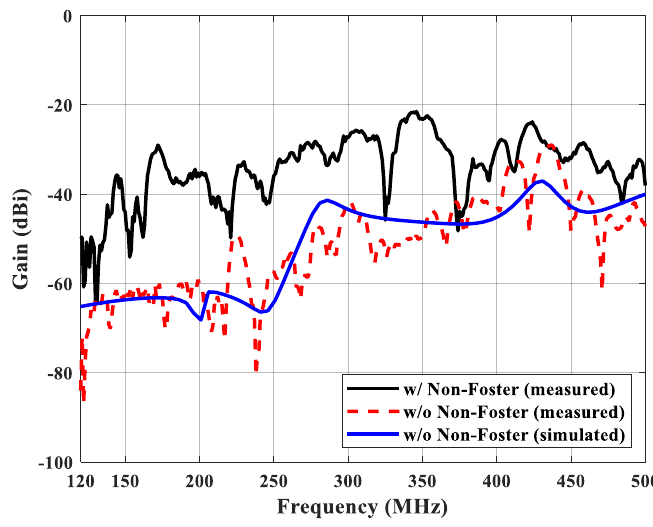
Figure 19. Measured and simulated gain of the antenna (note: “w / o Non-Foster” indicates the antenna was matched using ordinary passive matching technique).